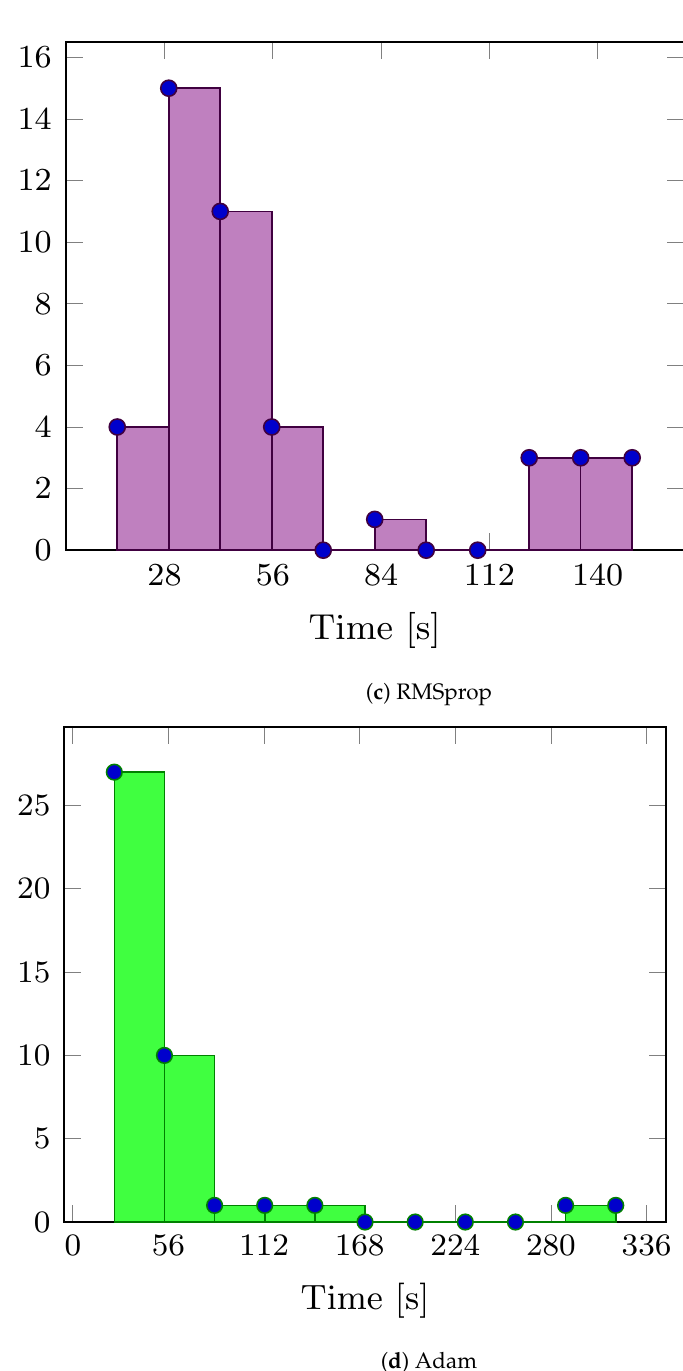
Figure 9. Histograms for the convergence time of each